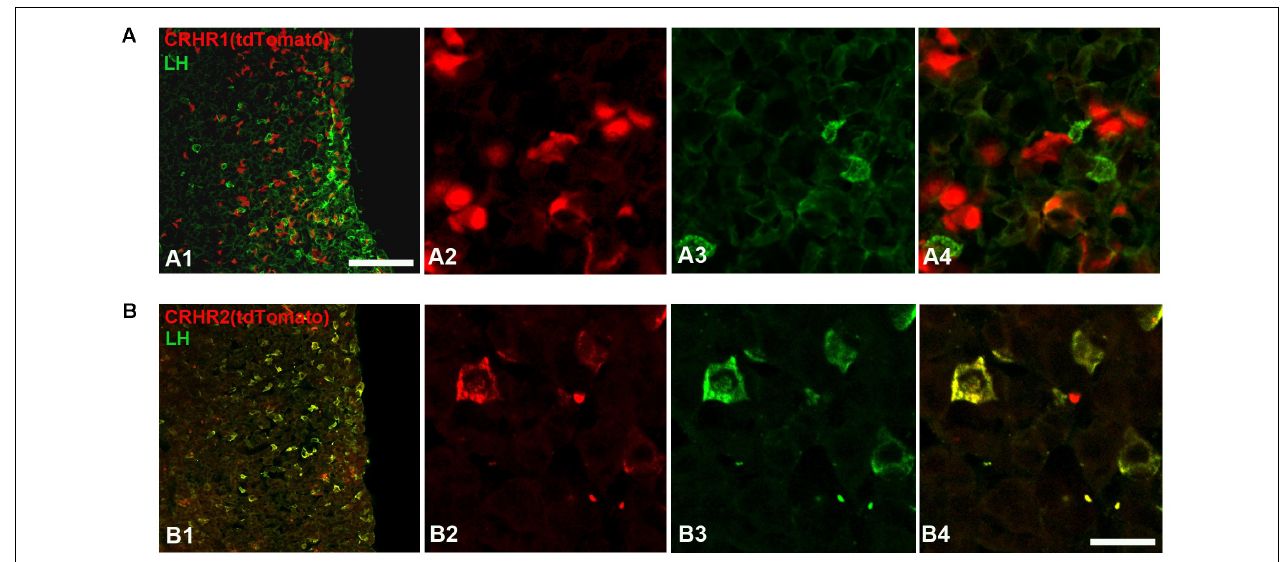
FIGURE 7 | Expression of CRHRs in gonadotropes. (A) Representative pituitary section from a CRHR1-Cre/Ai9 mouse (A1–A4) stained with an antibody against LH (green). TdTomato signal was not found in LH cells. (B) Pituitary section from a CRHR2-Cre/Ai9 mouse (B1,B2) immunostained for LH. The cytoplasm and initial process of virtually all LH cells contain tdTomato (appearing as a yellow signal in B4 ). Scale bars = 500 µ m (A1,B1) and 50 µ m (A2–A4, B2–B4)